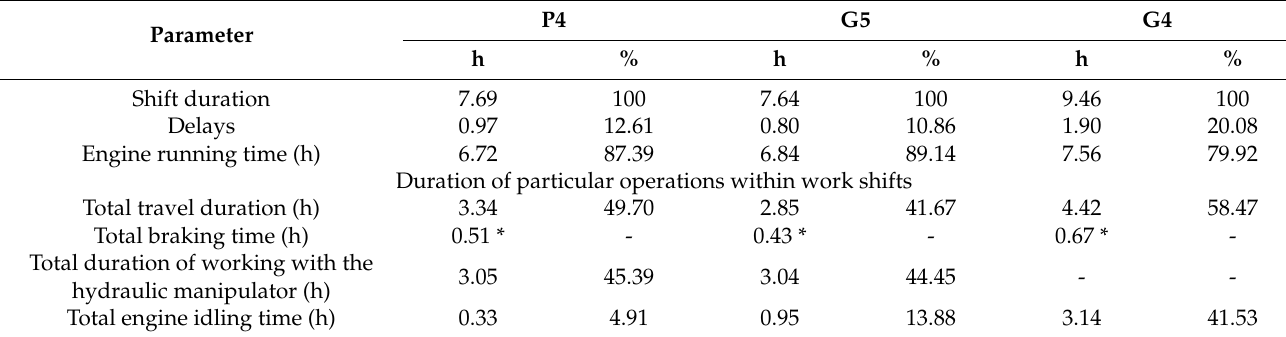
Table 5. Duration of selected operational parameters of the Scania P450 (P4), G500 (G5), and G440 (G4) logging trucks during the work shifts and their share on the total shift duration in